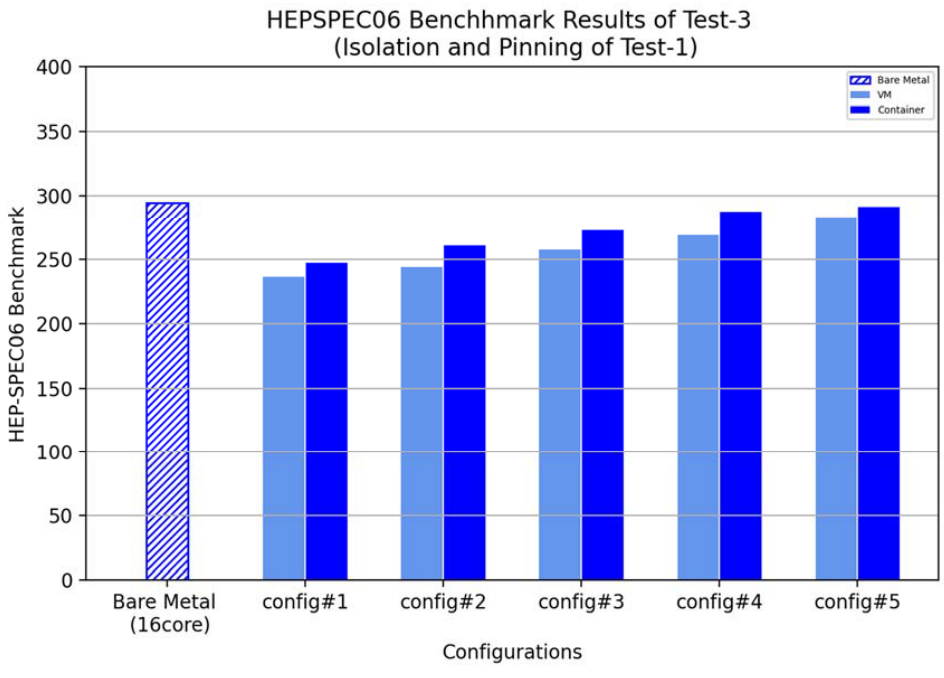
Figure 4. HEPSPEC06 benchmark results of test-3.